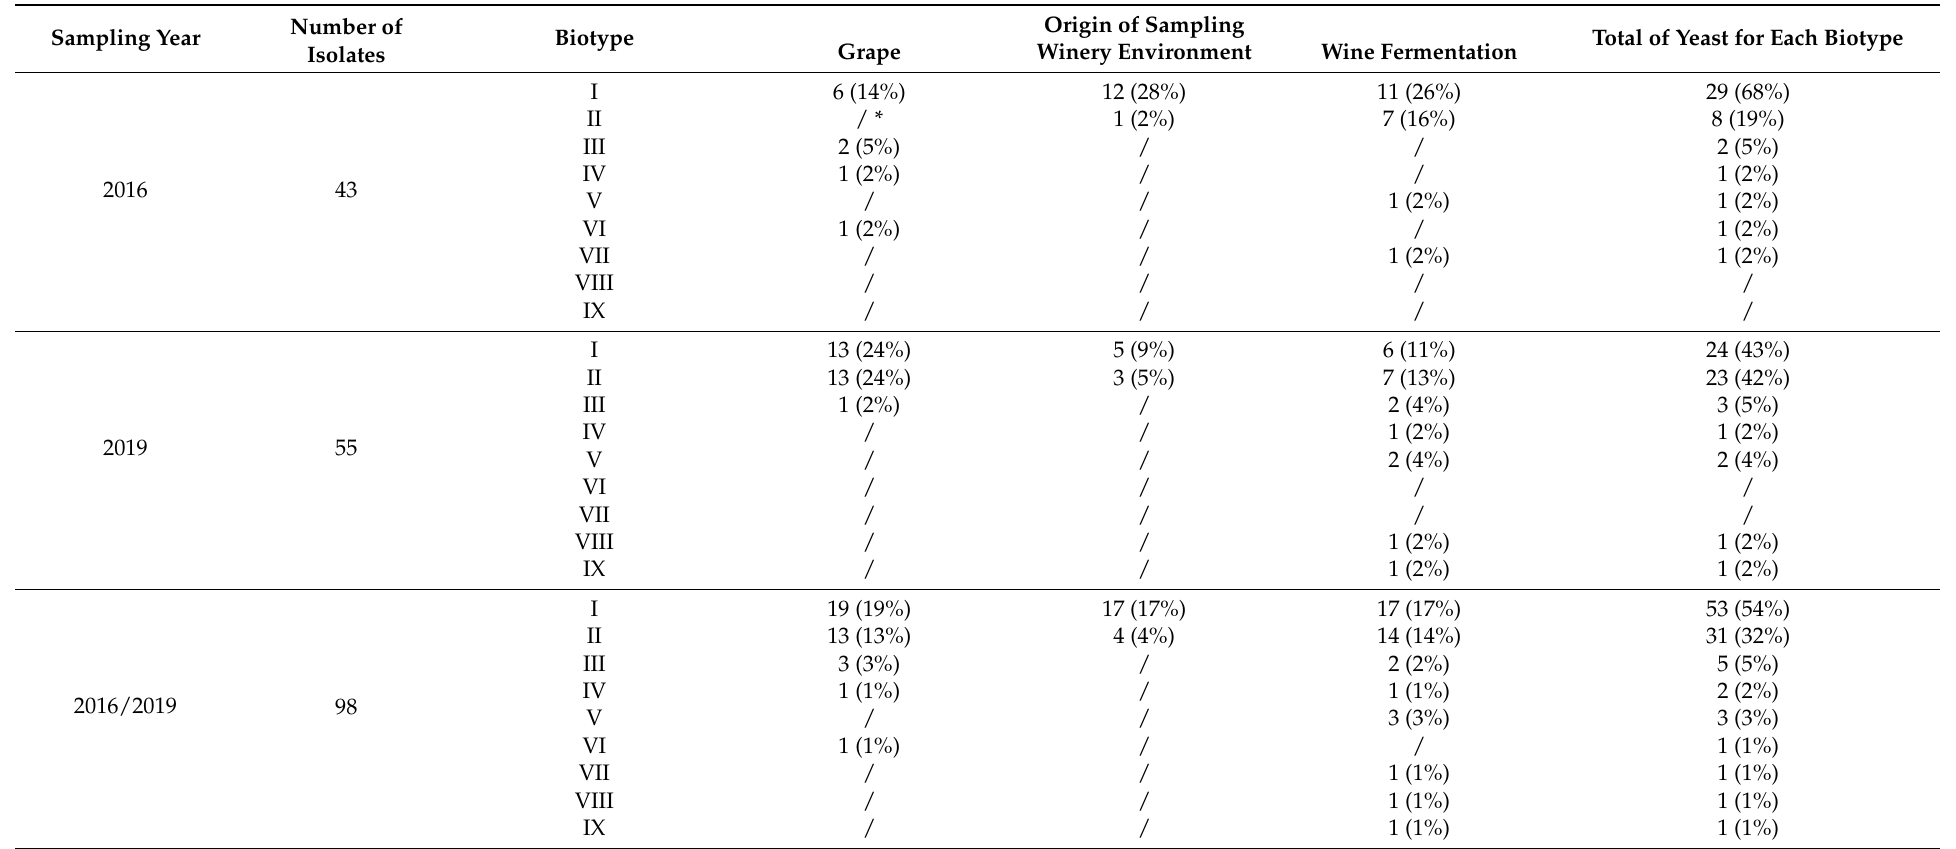
Table 2. Occurrence of S. cerevisiae biotypes in different years and samples. Percentage values were calculated on the basis of the number of isolates of the same year. For both vintages (2016/2019), the percentage values were calculated considering the sum of the isolates of both sampling years. * No presence of S. cerevisiae